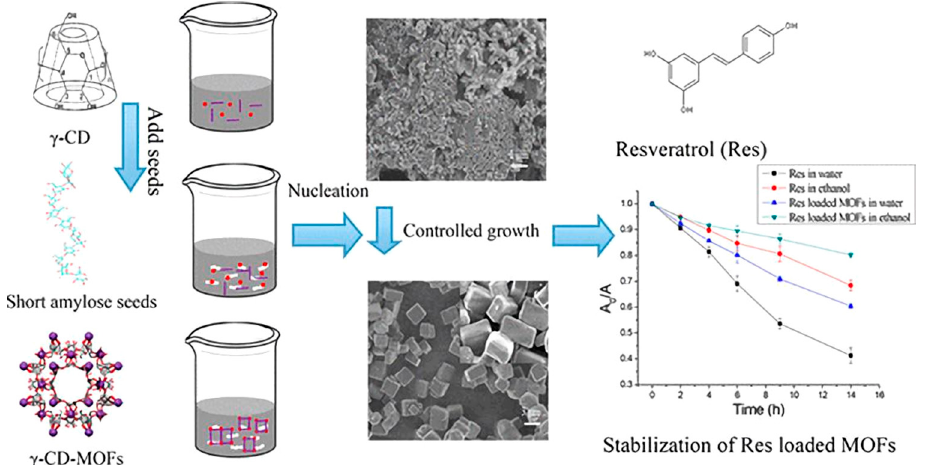
Figure 7. Schematic representation of the size-controlled synthesis of γ -CD-MOFs through facile and green seed-mediated method. Adapted from reference [244]. Copyright 2018 American Chemical Society.